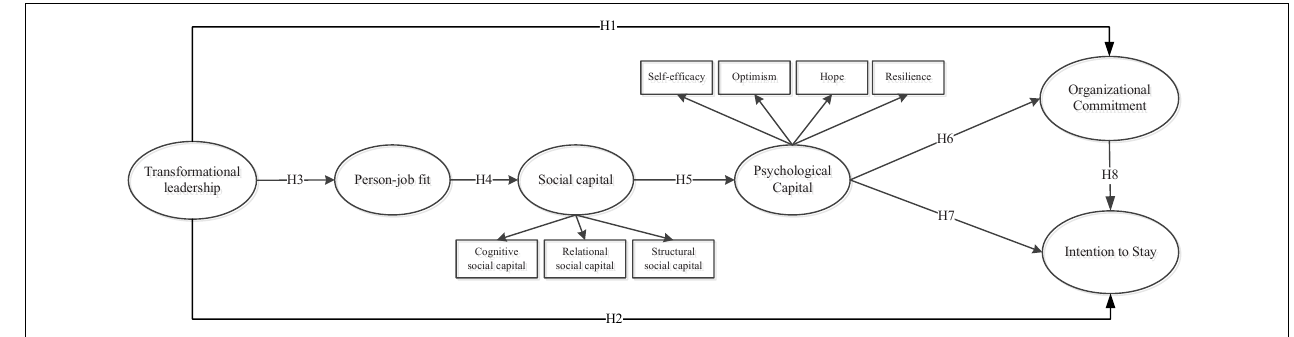
FIGURE 1 | Research framework.